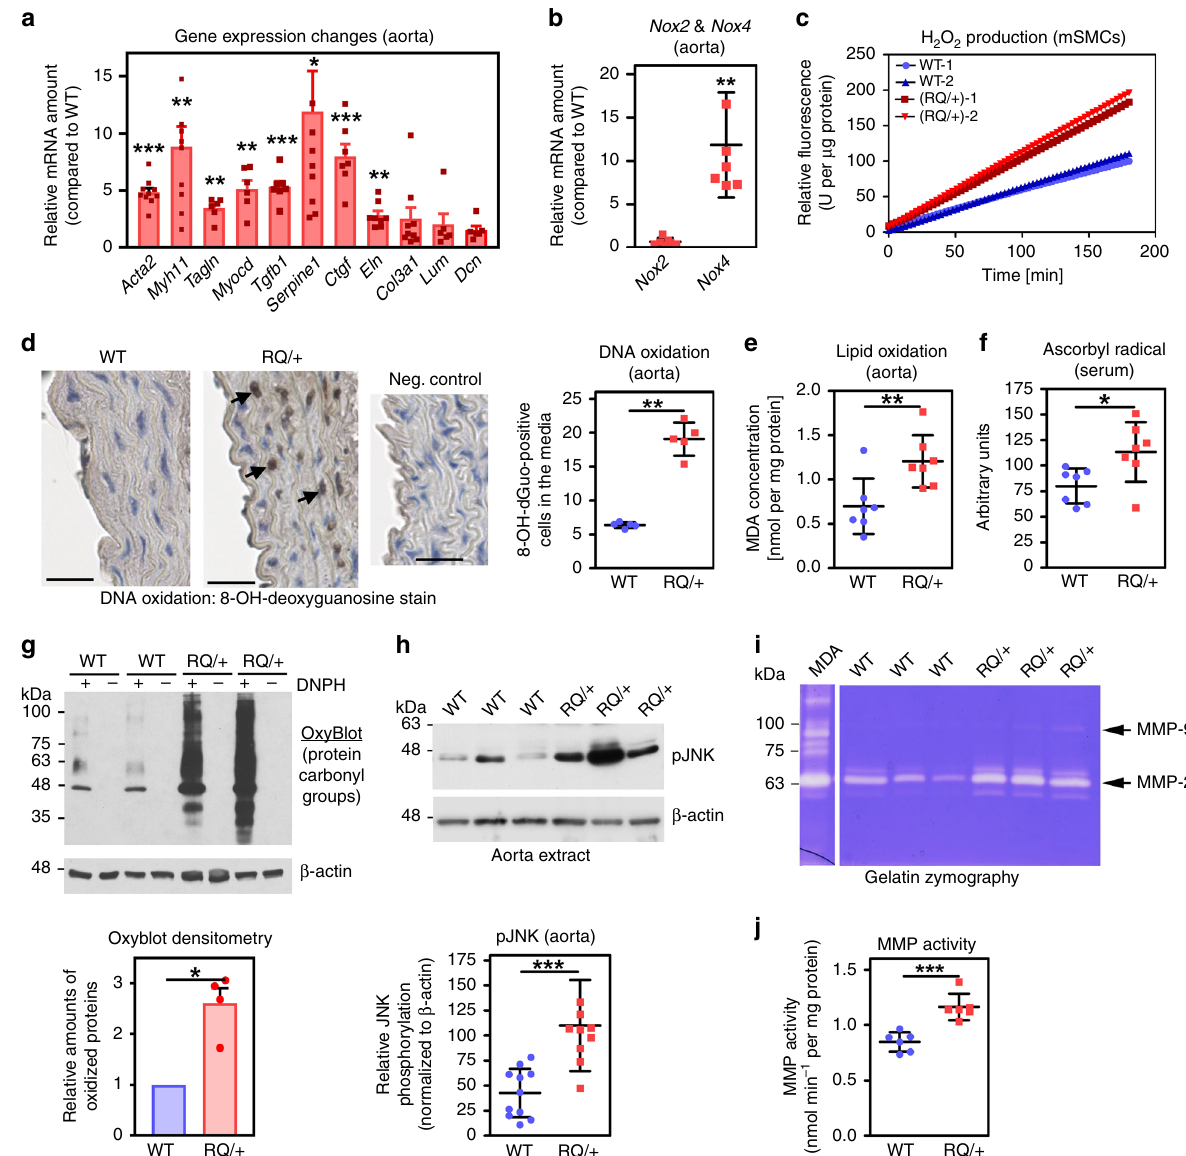
Fig. 2 Gene expression changes, Nox4 upregulation, oxidative stress, and increased MMP activity in Prkg1 RQ/ + aortas. a , b Relative mRNA expression in aortas of 4-month-old PKG1 RQ/ + mice compared to wild-type mice: smooth muscle α 2-actin ( Acta2 ); myosin heavy chain-11 ( Myh11 ); transgelin ( Tagln ); myocardin ( Myocd ); TGF- β 1 ( Tgfb1 ); plasminogen activator inhibitor-1 ( Serpine1 ); connective tissue growth factor ( Ctgf ); collagen3- α 1 ( Col3a1 ); elastin ( Eln ); lumican ( Lum ); decorin ( Dcn ); and NADPH oxidase-2 and -4 ( Nox2 , Nox4 ). Genes of interest were normalized to 18S rRNA and the mean Δ Ct of WT mice was assigned a value of one ( n = 3 – 4 M + 3 – 4 F mice per genotype). c H 2 O 2 production of aortic SMCs isolated from WT (in blue) and PKG RQ/ + (in red) mice measured over time by Amplex Red fl uorescence. d – g Oxidative stress markers measured in aorta and serum of 8- to 12-month-old WT and PKG RQ/ + mice. DNA oxidation was assessed by immunohistochemical staining of 8-OH-deoxyguanosine ( d : arrows point to examples of brown nuclei counted as positive; scale bar 50 μ m, n = 2 M + 3 F mice per genotype). Lipid peroxidation was assessed by measuring aorta malondialdehyde (MDA) content using thiobarbituric acid ( e , n = 2 M + 5 F mice). Ascorbyl radical was measured in serum by electron paramagnetic resonance ( f , n = 2 M + 5 F mice). Protein carbonyl groups were detected by OxyBlot TM after derivatization of aortic extracts with 2,4-dinitrophenylhydrazine (DNPH); non-derivatized extracts served as control and reprobing with a β -actin antibody showed equal loading ( g , ImageJ quanti fi cation for n = 2 M + 2 F mice per genotype below). h JNK activation was assessed on western blots of aortic extracts using a phospho-speci fi c antibody, and was normalized to β -actin (ImageJ quanti fi cation for n = 4 M + 6 F mice per genotype below). i , j Metalloproteinase (MMP) activity was assessed in aortic extracts by gelatin zymography ( i , n = 1 M + 2 F mice per genotype) and measured using fl uorescently labeled elastin as a substrate ( j , n = 2 M + 4 F mice per genotype; conditioned medium from MDA-MB231 cells served as positive control). Graphs ( a , g ) show means ± SEM, other plots means ± SD; * p < 0.05, ** p < 0.01, *** p < 0.001 for the indicated comparisons by one-sample t -test (panels a , b , g ), two-sided t -test ( e , f , h , j ), or Mann – Whitney test ( d ). Source data are provided as